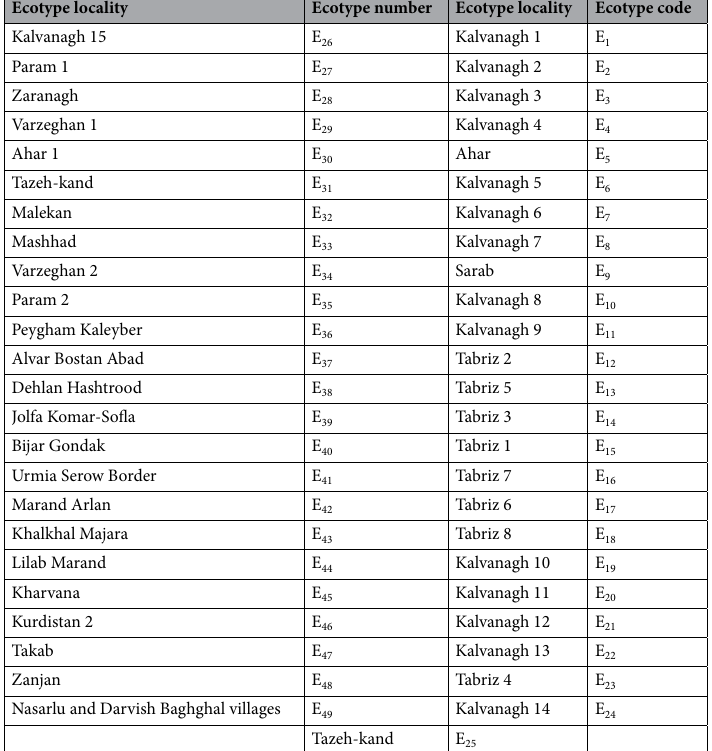
Table 8. Code and locality of Lallemantia iberica ecotypes were evaluated in this